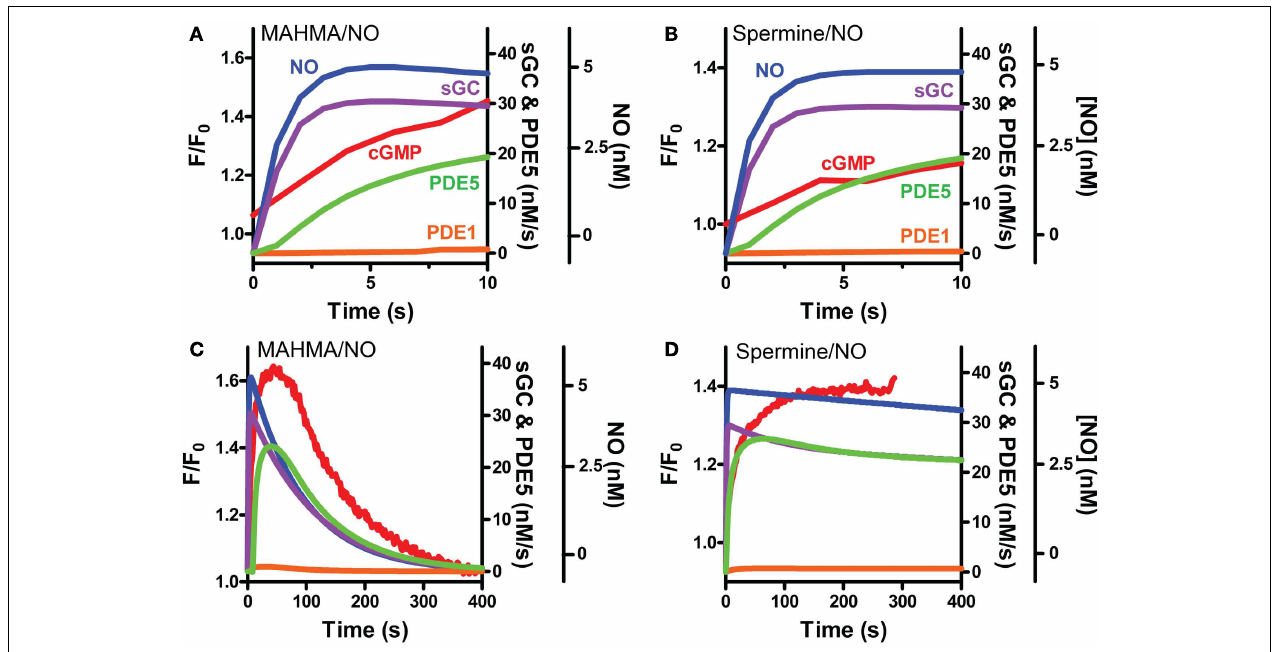
the corresponding NO concentrations (blue) and modeled enzymatic activities of sGC (purple), PDE5 (green) and PDE1 (orange). Enlargement of the first 10s for pulsed and clamped NO [ (A) and (B) ,